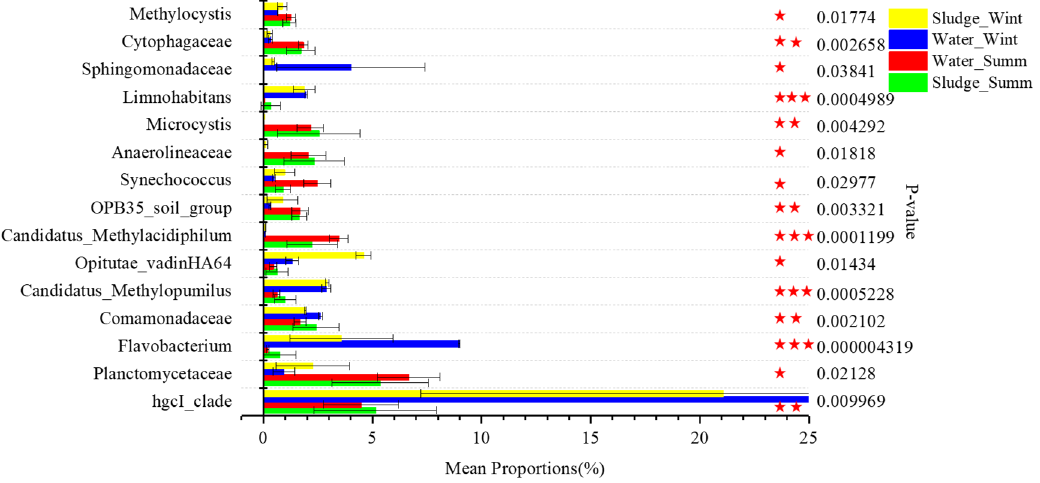
Figure 4. Significant differences in genera in four groups (the error bars mean standard deviation, whereas the stars mean the extent of the significant difference).